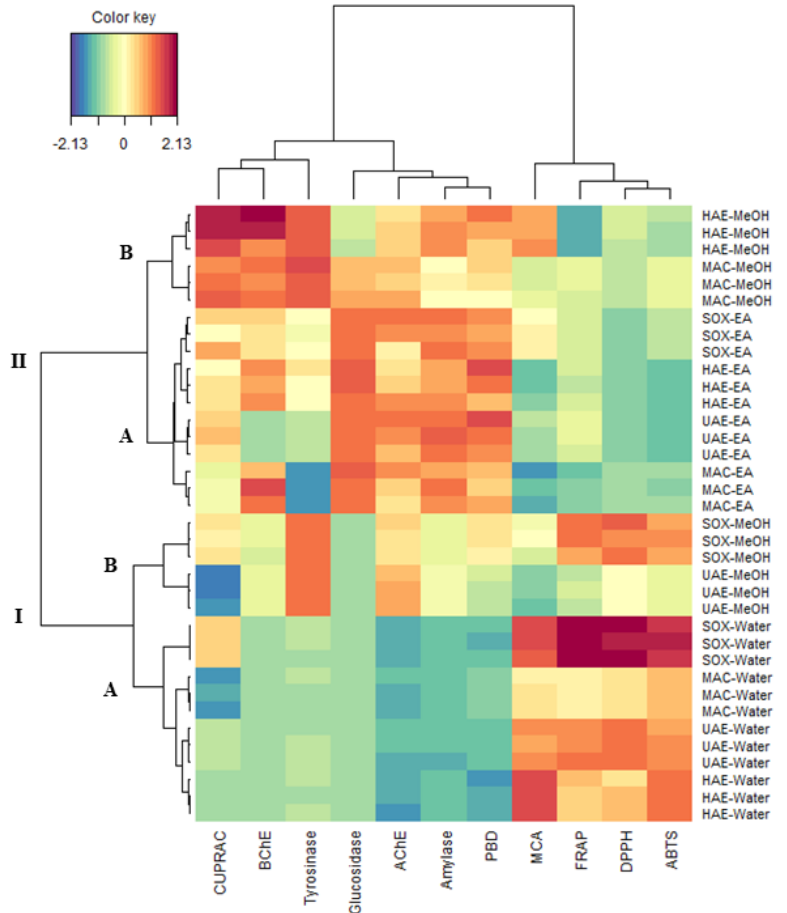
Figure 5. Clustered image maps on the biological activities of Alcea fasciculiflora extracts. Red colour: Highest activity. Blue Colour: Lowest